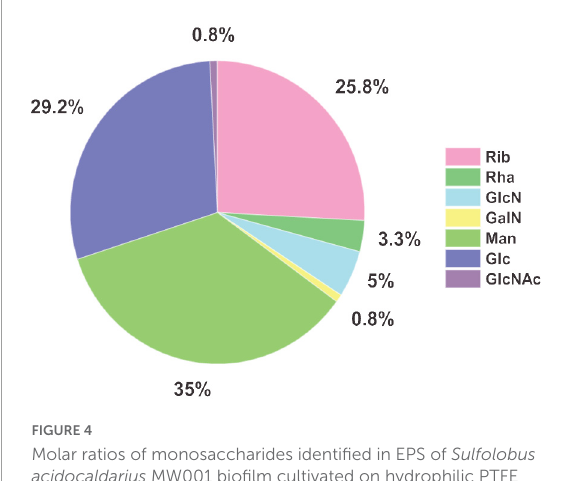
FIGURE4 Molar ratios of monosaccharides identified in EPS of Sulfolobus acidocaldarius MW001 biofilm cultivated on hydrophilic PTFE membranes at 76 ◦ C for 4 days (liquid Brock medium, pH 3.0, 0.1% ( w/v ) NZA, 0.2% ( w/v ) glucose, 10 µ g/mL uracil) ( n = 3). Values and standard deviations of the biological replicates are given in Supplementary Table 5